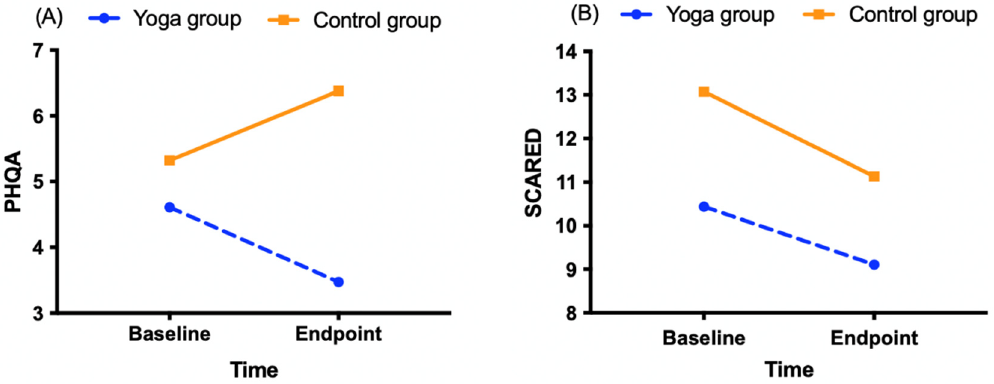
Figure 3. Change in mean scores on PHQA and SCARED scores for intervention and control groups on Baseline and Endpoint. ( A ) PHQA score in total sample; ( B ) SCARED score in total sample. Table 3. Overall test and mean difference between intervention and control groups for the outcomes in GEE analysis. MD